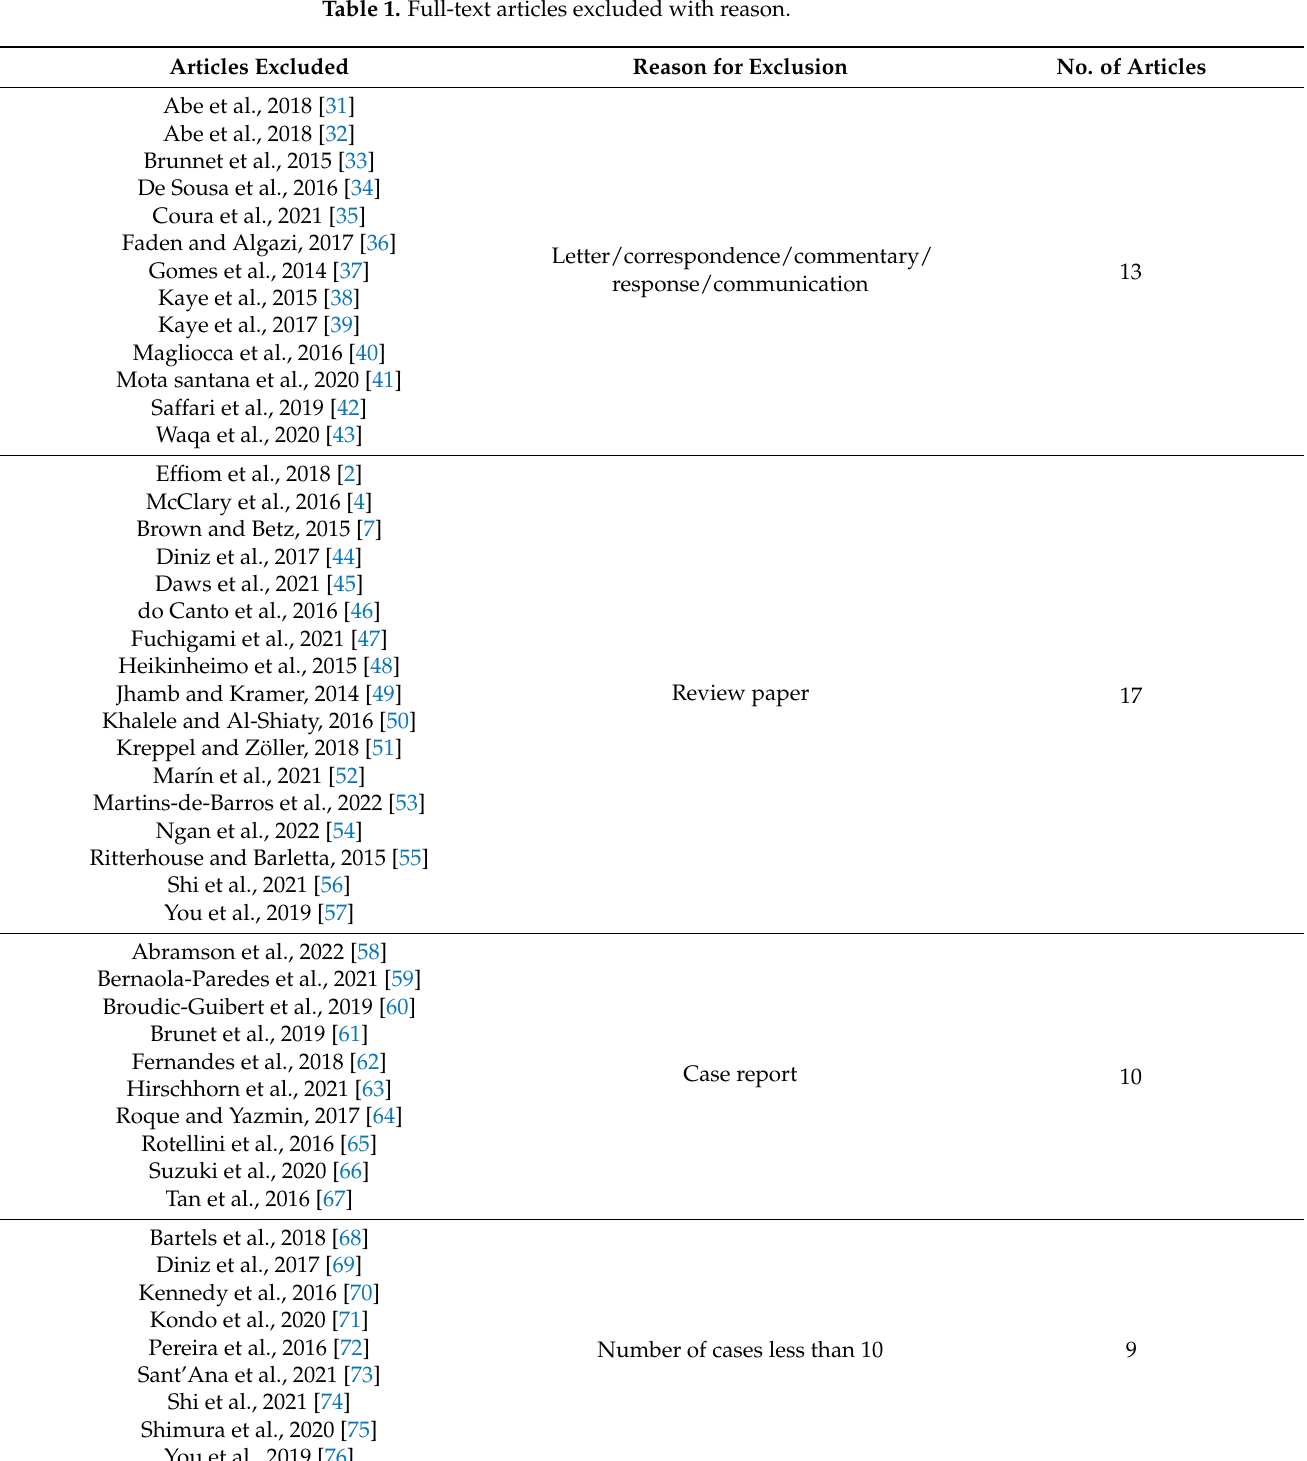
Table 1. Full-text articles excluded with